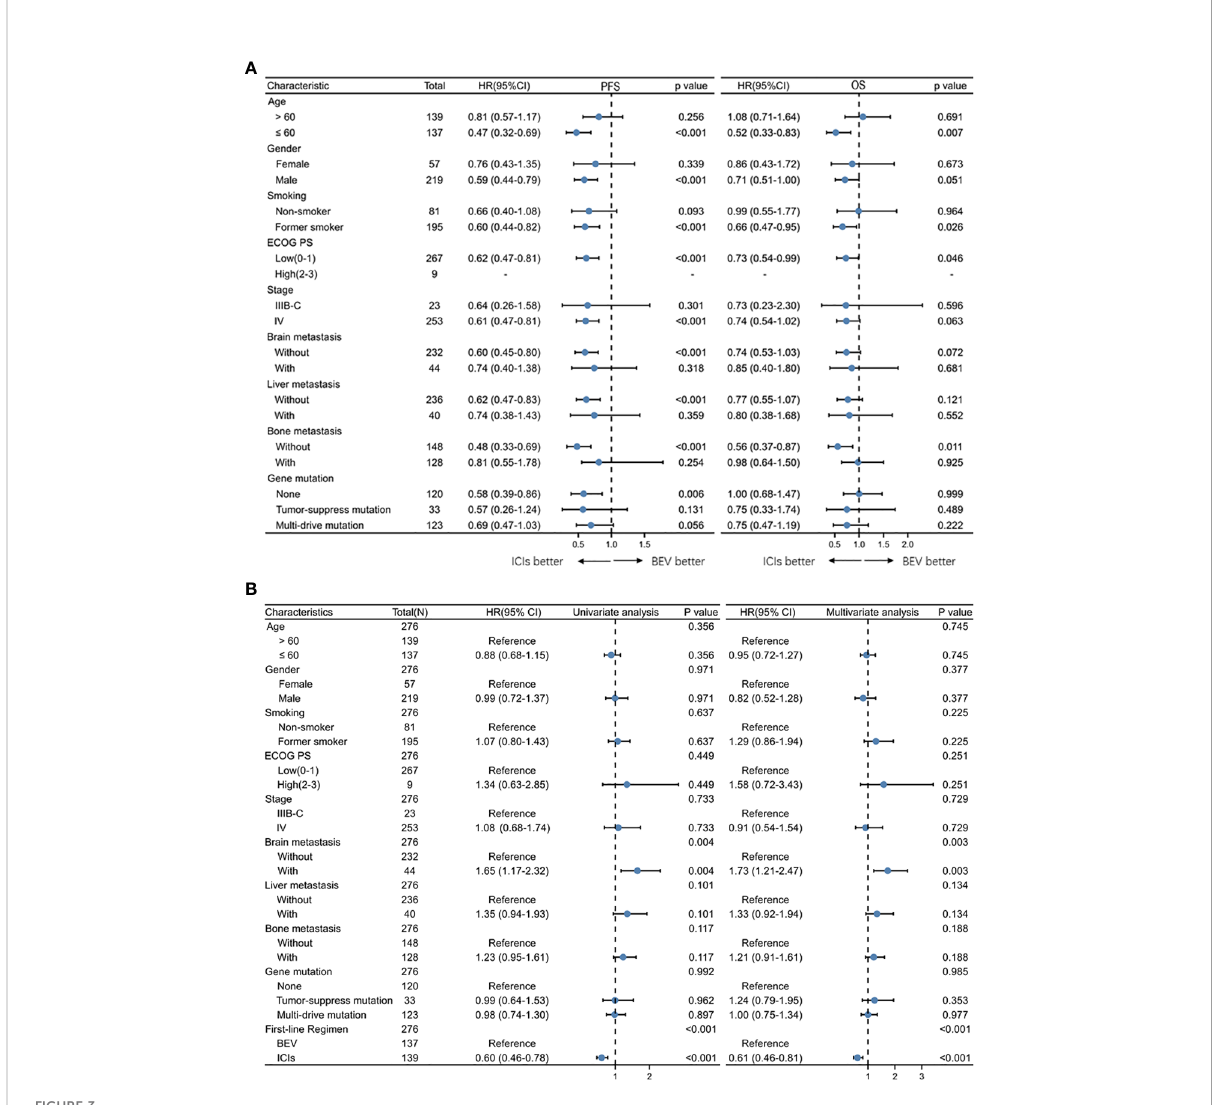
FIGURE 3 (A) Forest plots of hazard ratios for progression-free survival by subgroup for BEV + Chemotherapy and ICI + Chemotherapy group. (B) Univariate and multivariate Cox regression analysis of clinical characteristics of all